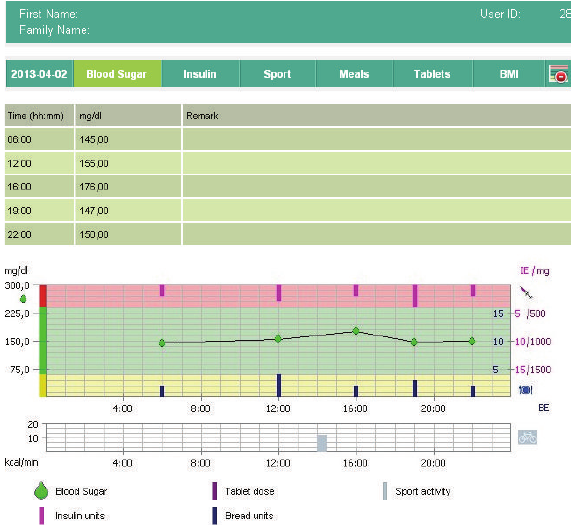
Figure 4: Mobil Diab web application: doctors’ portal and glucose day